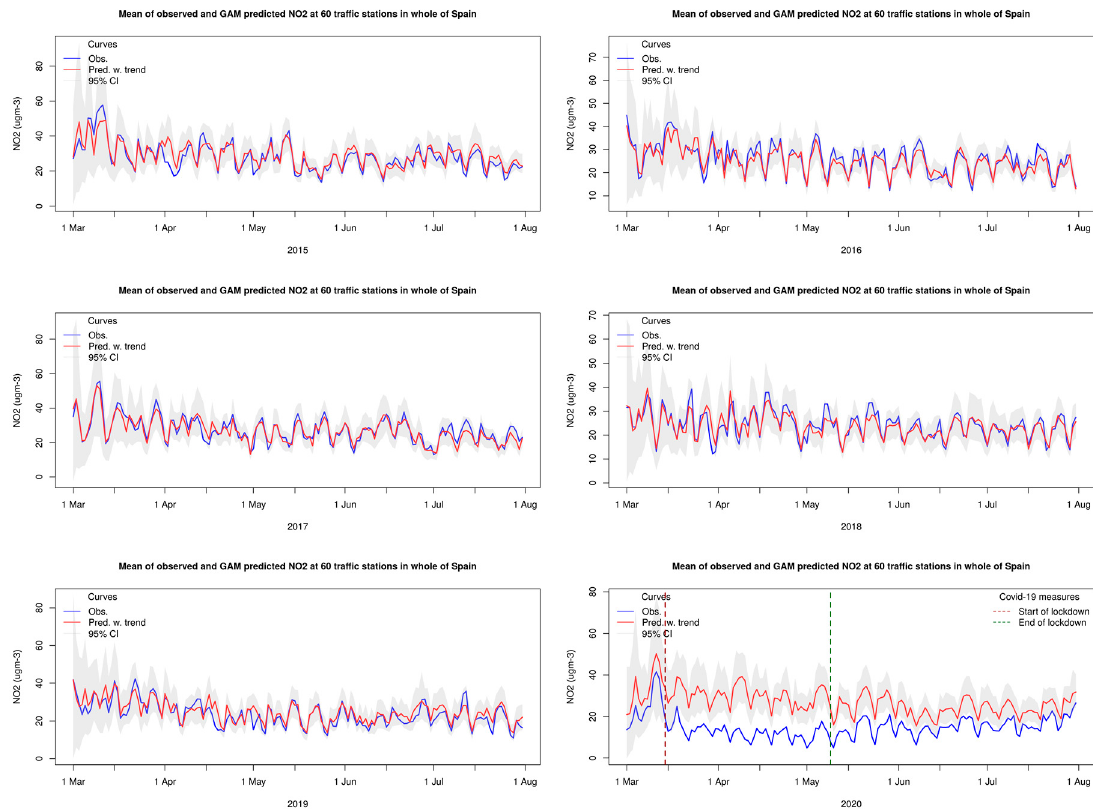
Figure 8. Daily mean NO 2 levels as observed (blue) and predicted (red) by the GAM for 60 traffic stations in Spain during 8 March–July 2015–2020. The start and end of the lockdown in 2020 are indicated in the plot. Grey shading indicates the 95 percent uncertainty in the prediction interval for each day, as explained in Section